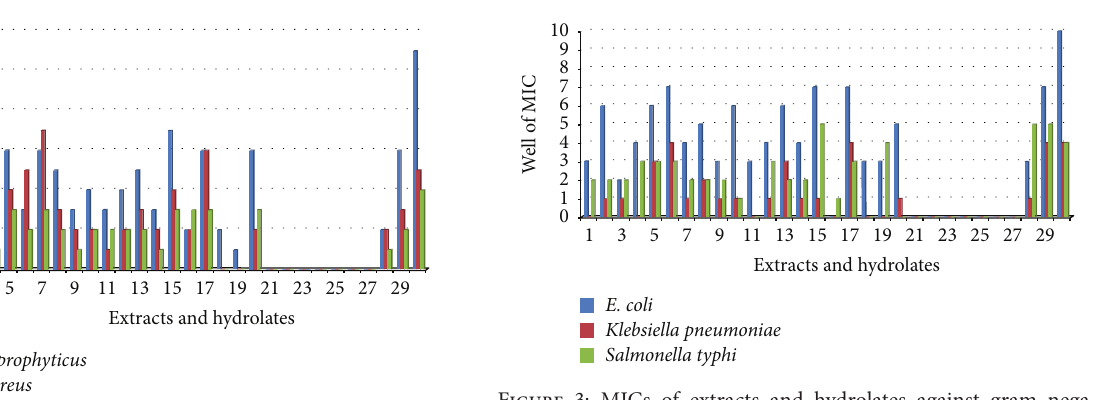
Figure 3: MICs of extracts and hydrolates against gram nega- tive bacteria species: Escherichia coli, Klebsiella pneumoniae, and Salmonella typhi. 1–30 =